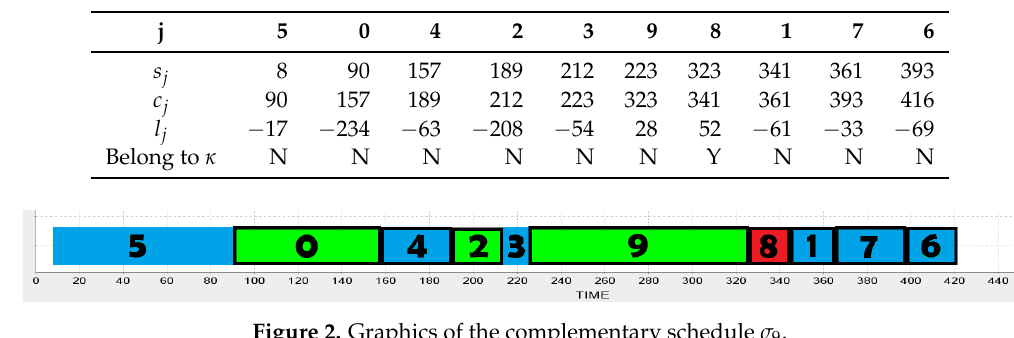
Table 4. Table for the complementary schedule σ 9 .